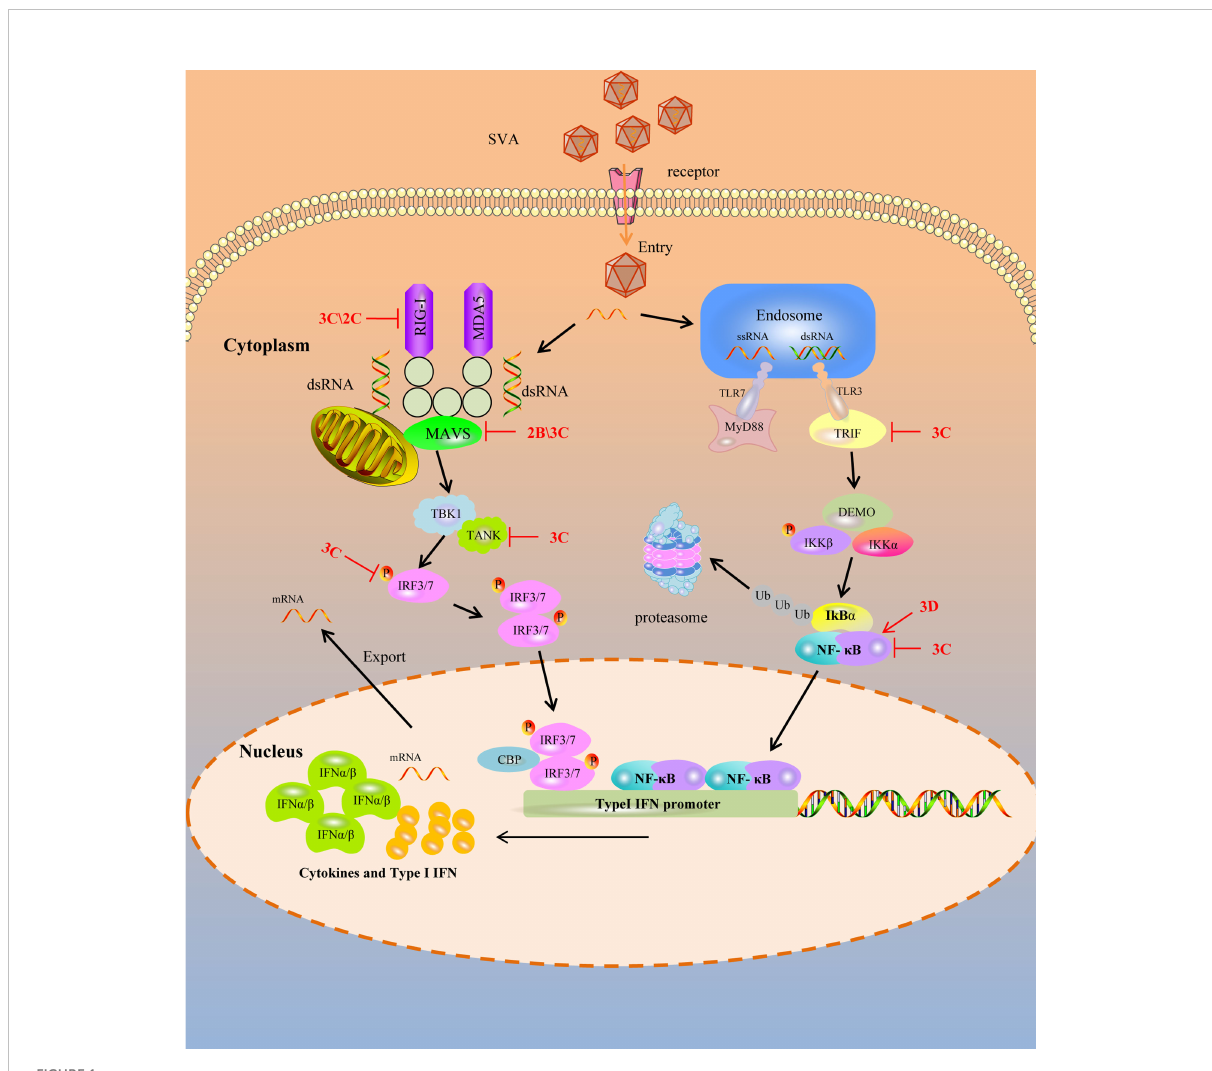
FIGURE 1 SVA escapes PRR mediated IFN-I signaling pathway. Cytoplasmic RNA sensors, such as TLR3, TLR7, RIG-1 and MDA-5, recognize SVA RNA in the cytosol and trigger the generation of IFN-I by transmitting a series of signals. SVA protein can target multiple steps in RLR-mediated IFN-I signaling pathway. The solid line represents the de fi ned interaction between the adaptor and the SVA protein. The red arrow represents the promoting effect, and the red T-shaped symbol represents the inhibiting